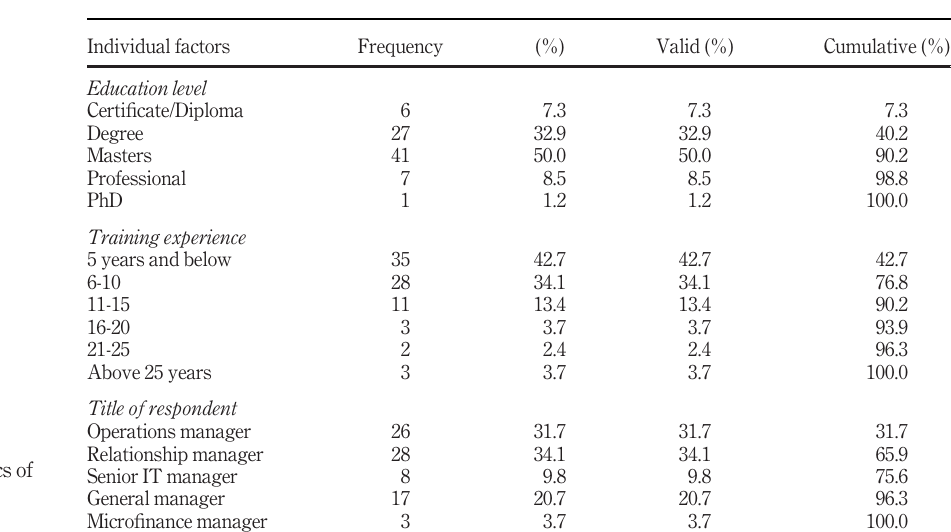
characteristics of individual